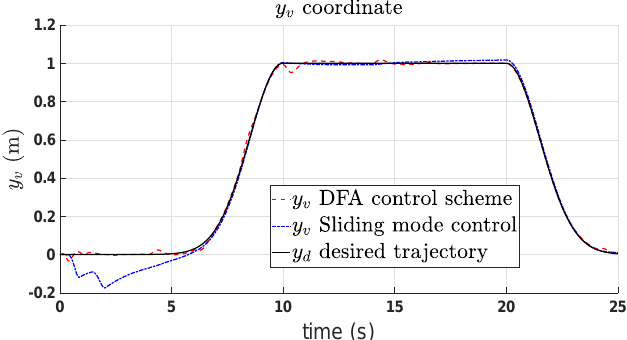
Figure 8. Behavior of y v with the proposed control scheme and with the sliding mode control in trajectory tracking